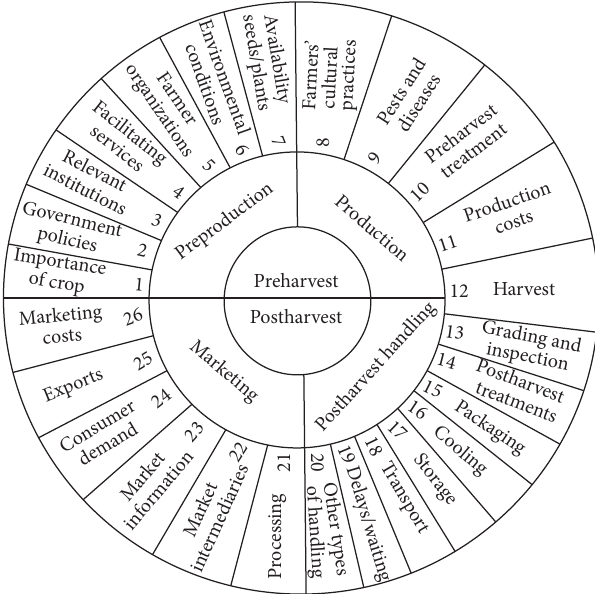
Figure 1: Components of the CSAM [6,